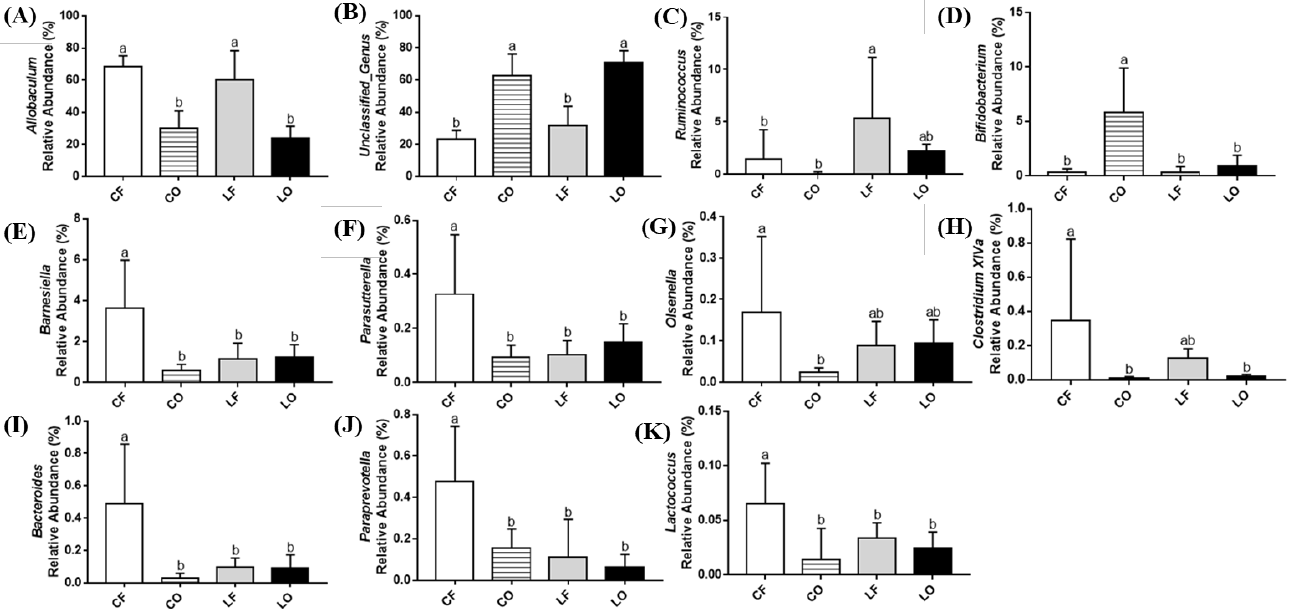
Figure 10. Genus level changes in bacterial composition of hamsters fed one of the four diets: CF, fresh corn oil; CO, oxidized corn oil; LF, fresh lard; LO, oxidized lard. Comparison of relative abun- dances of: ( A ) Allobaculum , ( B ) Unclassified_Genus ( C ) Ruminococcus , ( D ) Bifidobacterium , ( E ) Barnesiella , ( F ) Parasutterella , ( G ) Olsenella , ( H ) Clostridium XIVa, ( I ) Bacteroides , ( J ) Paraprevotella , and ( K ) Lactococcus. Data are expressed as mean ± S.D., where different letters indicate statistical difference, p < 0.05.